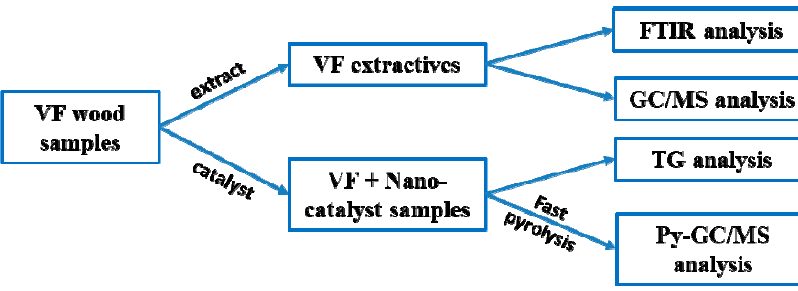
Figure 1. The flow chart of forestry wood waste pyrolysis procedure (Note: VF is the abbreviation of Vernicia fordii ).